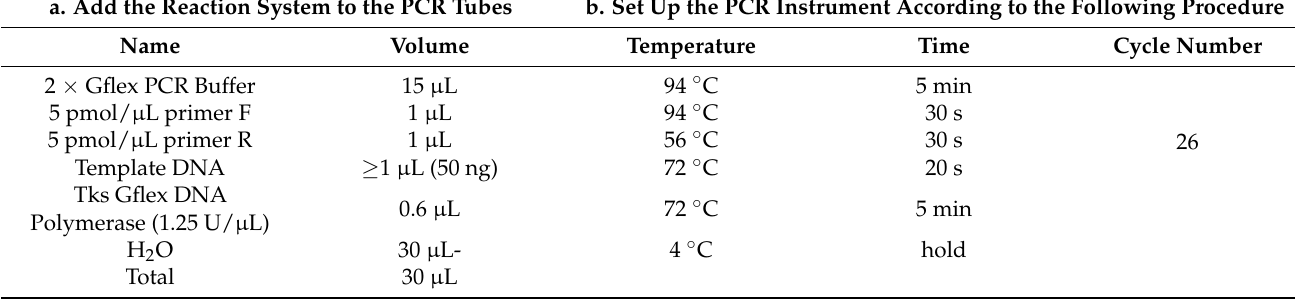
Table 7. First Round PCR Reaction.